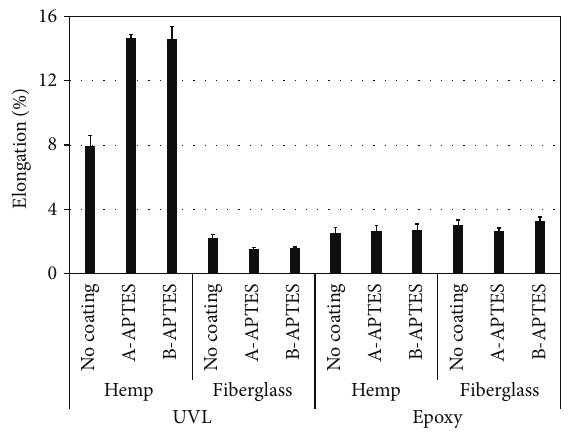
Figure 6: Effect of fiber coating on percent elongation of epoxy and UVL composites.